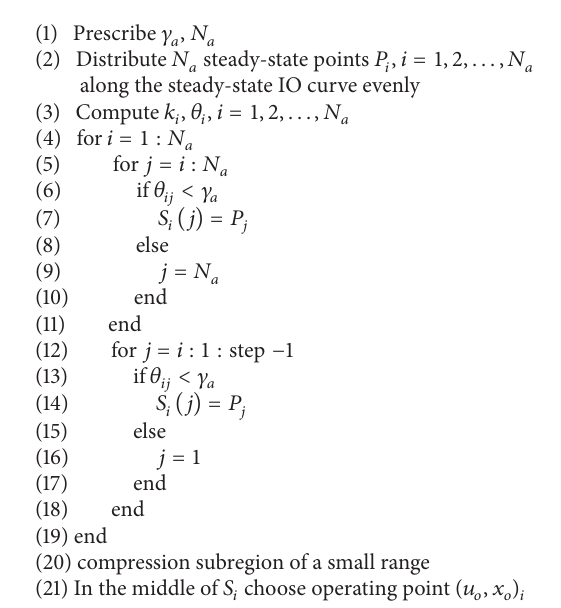
Algorithm 2: Algorithmic view of the modified IAD method.